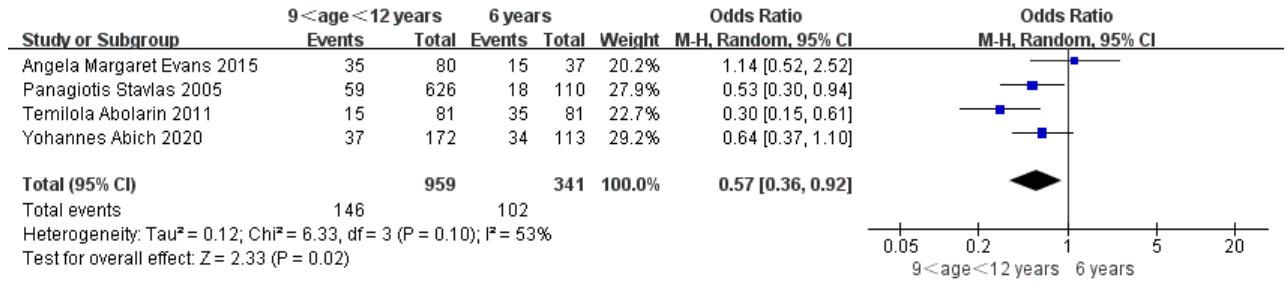
Figure 9. The forest plot of age 9–12 years for flatfoot in children [7,11,17,20].